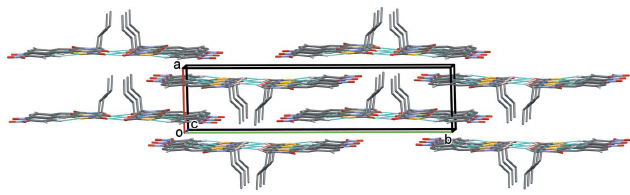
Figure 3 A view along the c axis of the crystal packing of the title compound. Dashed lines indicate hydrogen bonds (Table 1) and H atoms not involved in these interactions have been omitted.